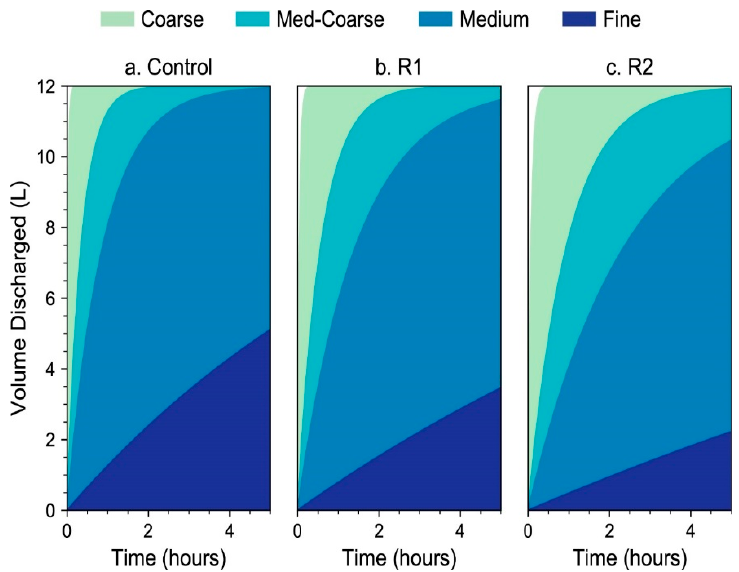
Figure 4. Modeled volume discharged vs. time at varying sand media for ( a ) a traditional BSF design (control); ( b ) a 40% reduced-height design (R1); and ( c ) a 70% reduced-height design (R2). Color fills are used to represent a range between given media such as that between coarse and medium–coarse sand.